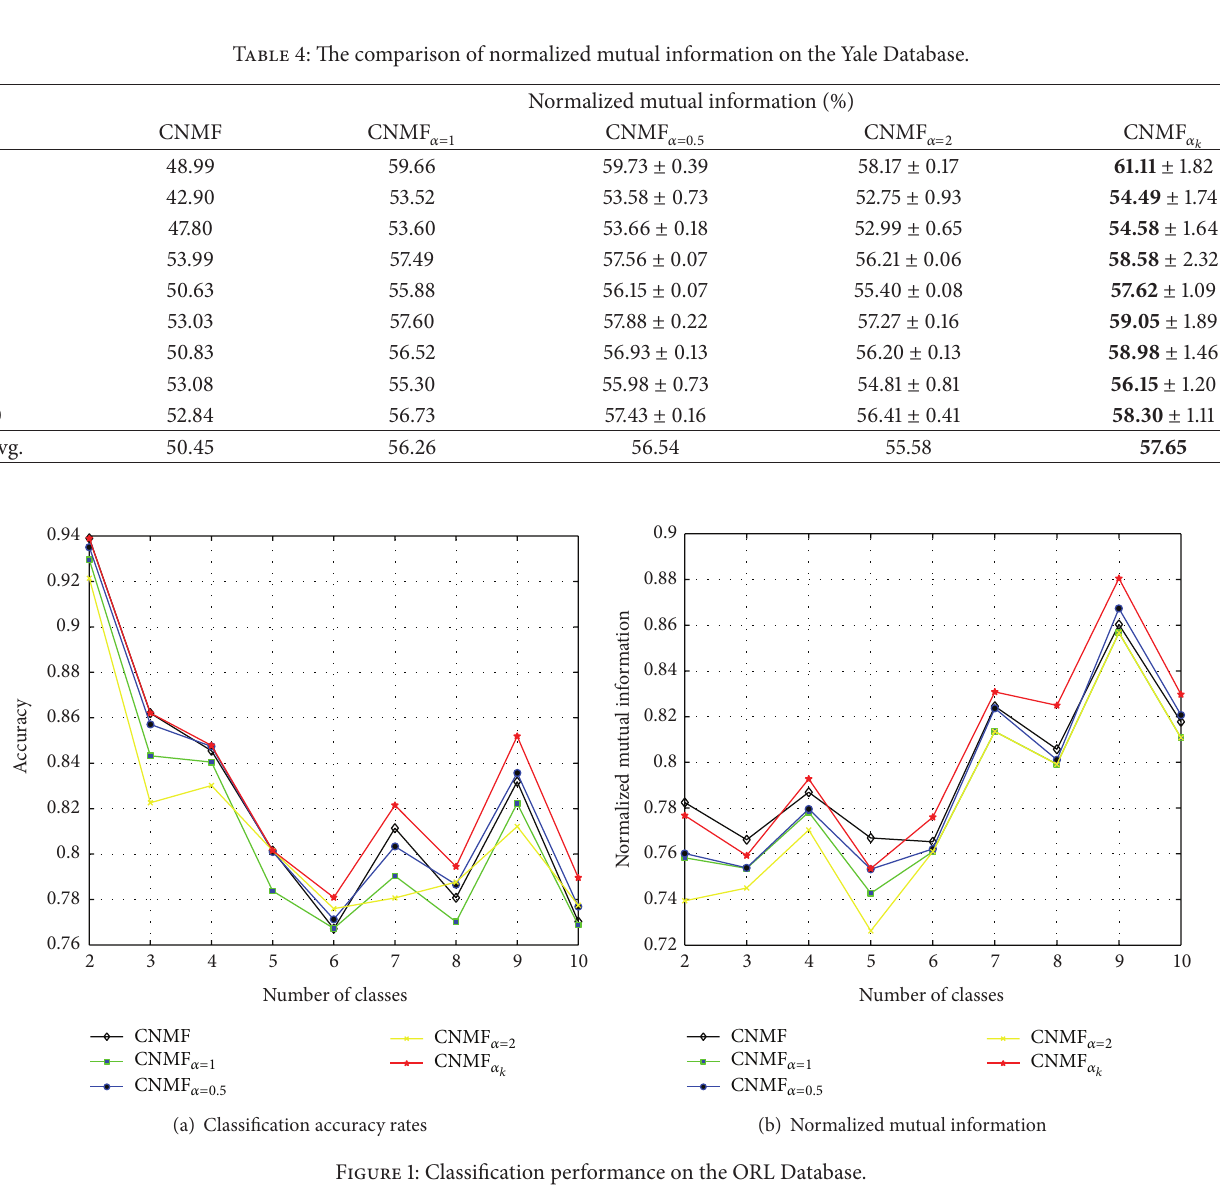
Figure 1: Classification performance on the ORL